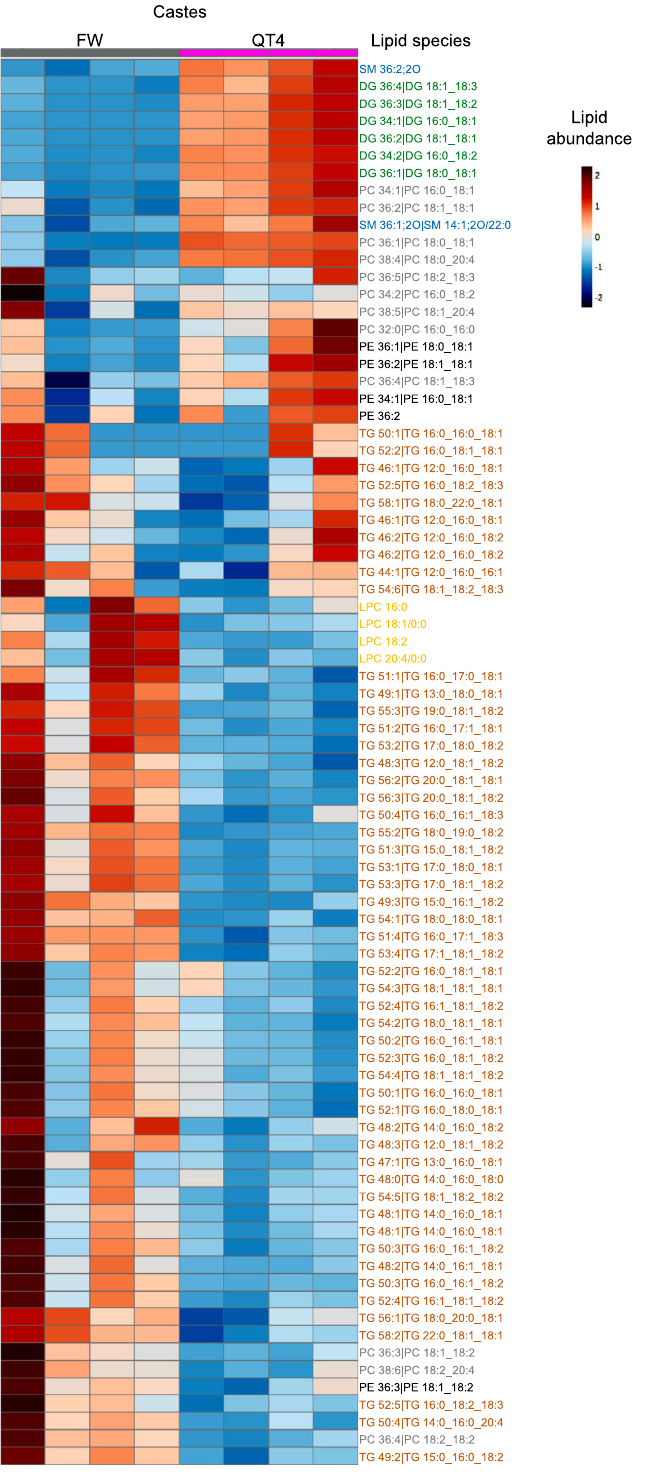
Fig. 7 Comparison of lipid pro fi les between FW and QT4 in hemolymph. Hierarchical clustering heatmap analysis of triglycerides (TG, orange), diglycerides (DG, green), phosphatidylethanolamine (PE, black), phosphatidylcholine (PC, gray), lysophosphatidylcholine (LPC, yellow), sphingomyelin (SM, blue) lipids in hemolymph of FW and QT4 performed in MetaboAnalyst 4.0. Individual lipids are shown in rows and samples displayed in columns, according to cluster analysis (Euclidian distance was used and Ward ’ s clustering algorithm). The color gradient, ranging from dark blue through white to dark red, represents low, middle, and high abundance of a lipid. Numbers of replicates per group are provided in Supplementary Table